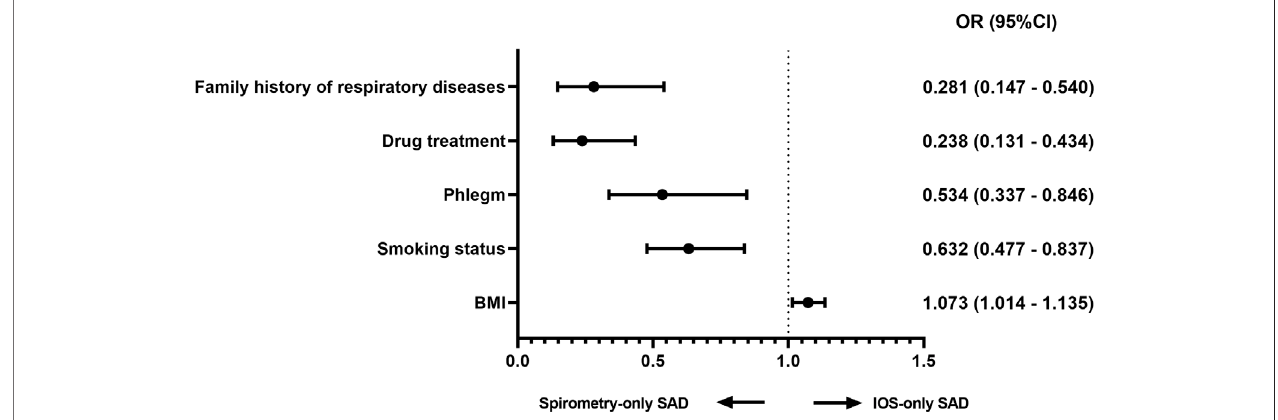
FIGURE 1 | Factors associated with discordance (multivariable logistic regression) Adjusted analysis comparing IOS-only SAD and spirometry-only SAD in all subjects adjusted for age, sex, BMI, smoking status, and smoking index. Abbreviations: OR, odds ratio; BMI, body mass index.